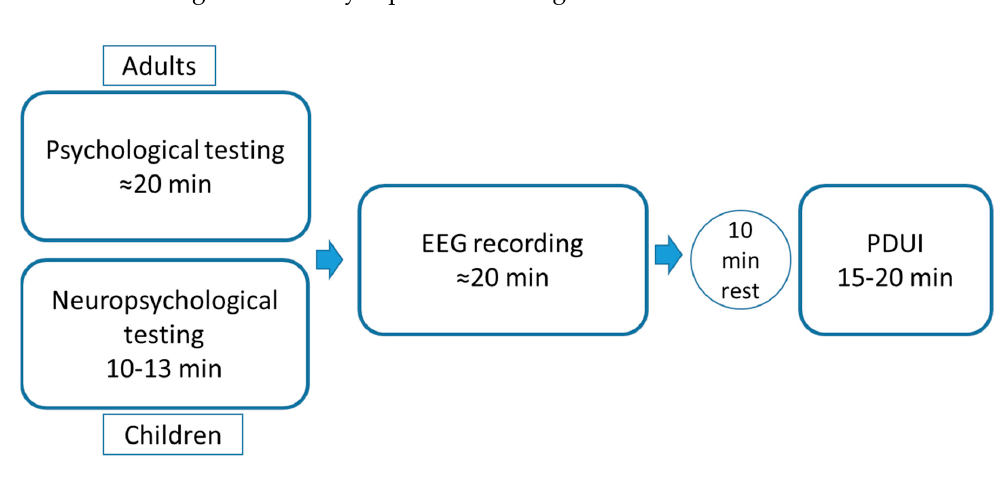
Figure 1. Schematic design of the study.